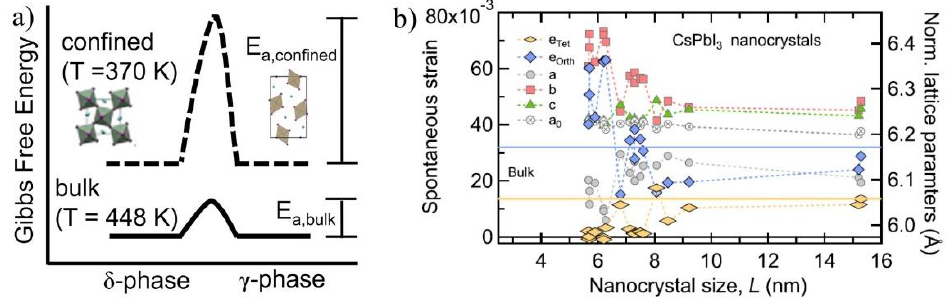
Figure 4. ( a ) Energy diagram representation to differentiate the α -to- δ ph ase transition in bulk CsPbI 3 and CsPbI 3 NCs (confined). Adapted with permission from Ref. [73]; Copyright 2019 American Chemical Society. ( b ) Normalized lattice parameters and corresponding spontaneous strains found in CsPbI 3 NCs for various crystal sizes (L). Adapted with permission from Ref. [41]. Copyright 2021 American Chemical Society.